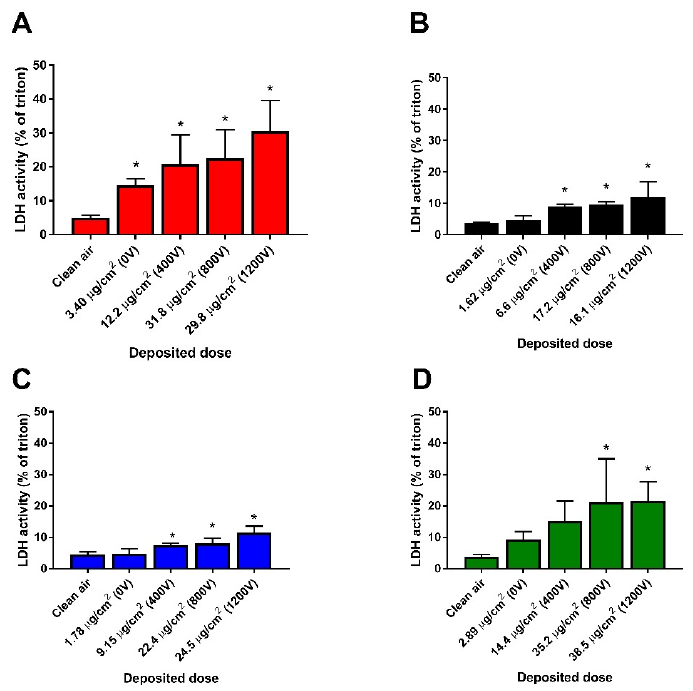
Figure 4. LDH activity measured in HBE cell supernatants after 4 h exposure to TiO 2 agglomerates at the ALI. 17 nm-SA ( A ), 17 nm-LA ( B ), 117 nm-SA ( C ), and 117 nm-LA ( D ). Data are expressed as means ± SD from three independent experiments with six replicates each. p < 0.05 (*) represent significant difference compared to control (One-way ANOVA followed by Dunnett’s multiple comparison test).